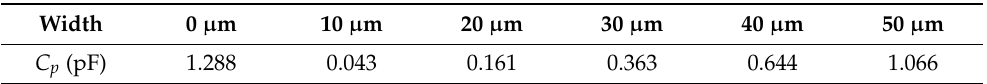
Figure 3. ( a ) Simulated impedance curve of a traditional FBAR and MBVD model fitting curve. ( b ) Simulated impedance curves of FBARs with support columns of different widths and parallel capacitor MBVD fitting curves. Table 1. Calculated capacitance with support columns of different